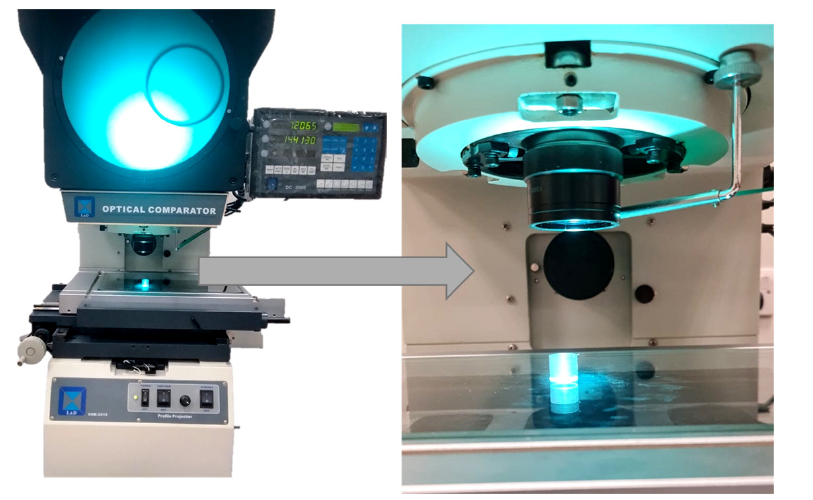
Figure 4. Pro fi le projector measurement system. Figure 4. Profile projector measurement